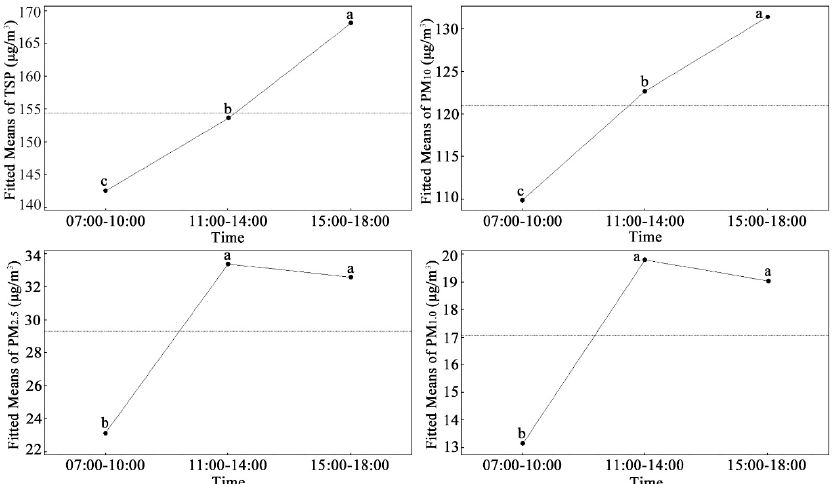
Figure 5. Differences of atmospheric suspended particulate matter concentration over different time periods. The lower-case letters in the figure represent the grouping information obtained by multiple comparisons of means using the Tukey method.